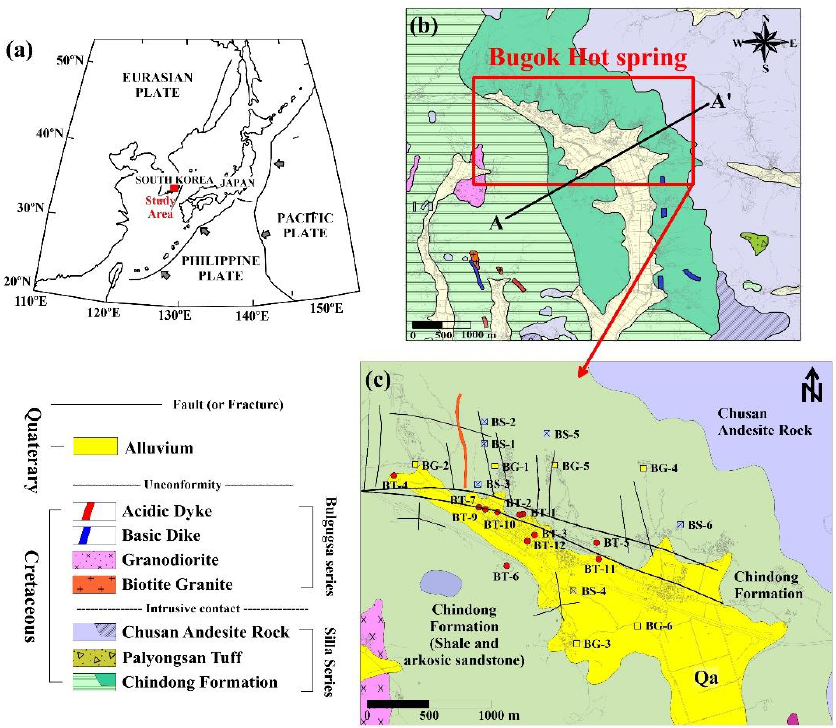
Figure 1. Location and geologic maps. ( a ) Northeast Asian plate tectonics including South Kore; ( b ) geologic map of Bugok area; ( c ) enlarged map of a rectangular box of geologic map ( b ) including the location of water samples.